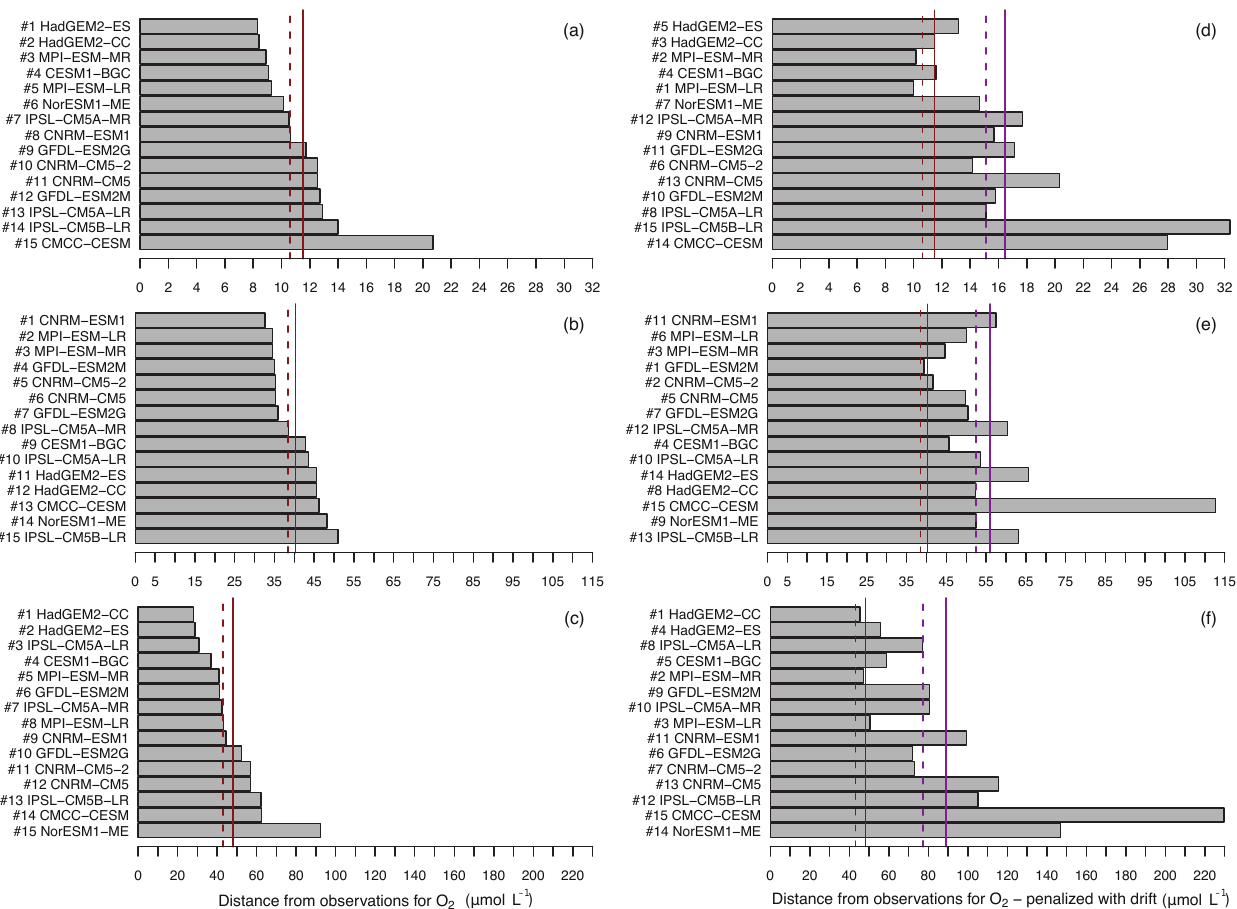
Figure 10. Rankings of CMIP5 Earth system models based on the standard and penalized version of the distance from oxygen observations. The standard distance metric is calculated as the ensemble-mean root-mean squared error (RMSE) for O 2 concentrations at surface (a) , 150m (b) and 2000m (c) . The penalized distance metric incorporates drift-induced changes in O 2 RMSE ( (cid:49) RMSE) into O 2 RMSE at surface (d) , 150m (e) and 2000m (f) . Ensemble-mean RMSEs are calculated using available ensemble members of Earth system model oxygen concentrations averaged over the 1986–2005 historical period relative to WOA2013 observations. (cid:49) RMSE is determined using Eq. (2) and fits derived from the first century of the CMIP5 piControl simulations. Solid red and magenta lines indicate the multi-model mean standard and penalized distance from O 2 observations, respectively. With the same color pattern, dashed lines are indicative of the multi-model median for the standard and penalized distance from O 2